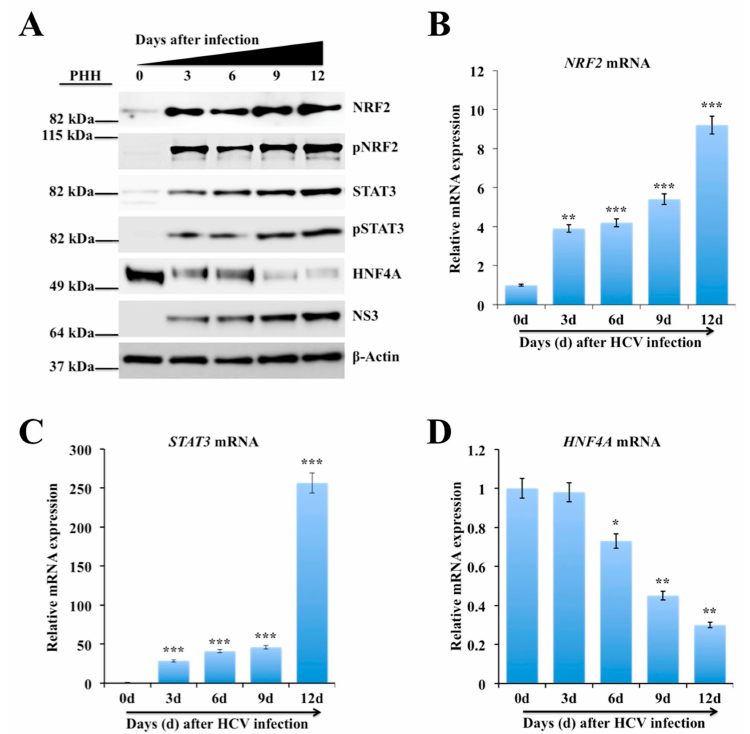
Figure 2. Hepatic stress response due to hepatitis C virus (HCV) replication in non-proliferative primary human hepatocytes (PHHs) activates nuclear factor erythroid 2-related factor 2 (NRF2)-mediated signal transducer and activator of transcription 3 (STAT3)-hepatocyte nuclear factor 4 alpha (HNF4A) expression. ( A ) Cell lysate was examined for the presence of HCV NS3 protein and for the activation of NRF2, STAT3 and HNF4A protein expression in infected PHH by Western blot. Messenger RNA (mRNA) levels of individual genes in HCV-infected PHHs were measured by real-time RT-PCR analysis. ( B ) Shown are NRF2 mRNA levels ( C ) Shown are STAT3 mRNA levels. ( D ) Shown are HNF4A mRNA levels. The results are expressed as the mean ± standard deviation (SD) of three experiments. Error bars represent SD. p -values were calculated by ANOVA as compared to day 0. * p -value < 0.05, ** p -value < 0.01, *** p -value <